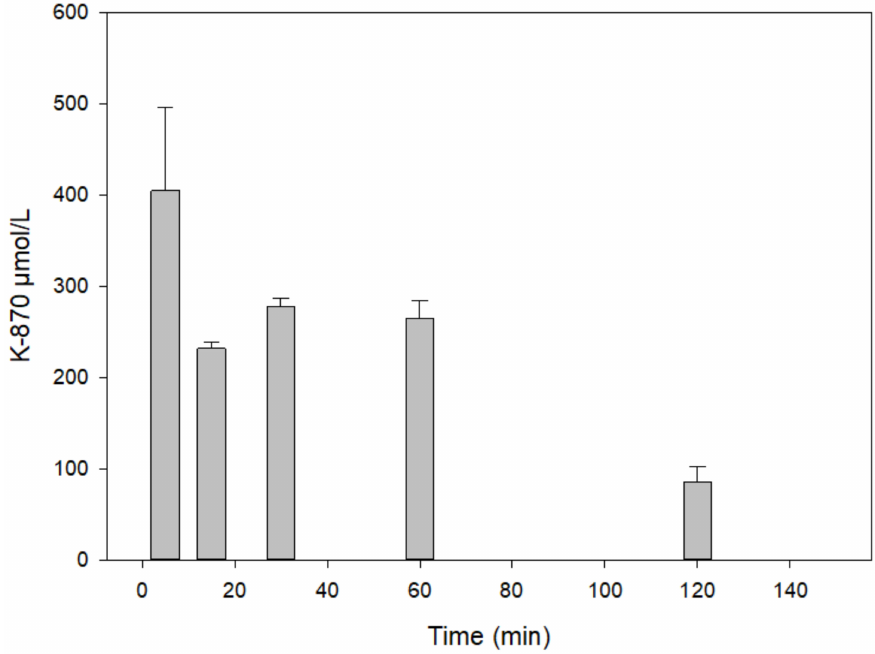
Figure 8. Time course of K870 content in the serum following its intramuscular administration of 100 µ